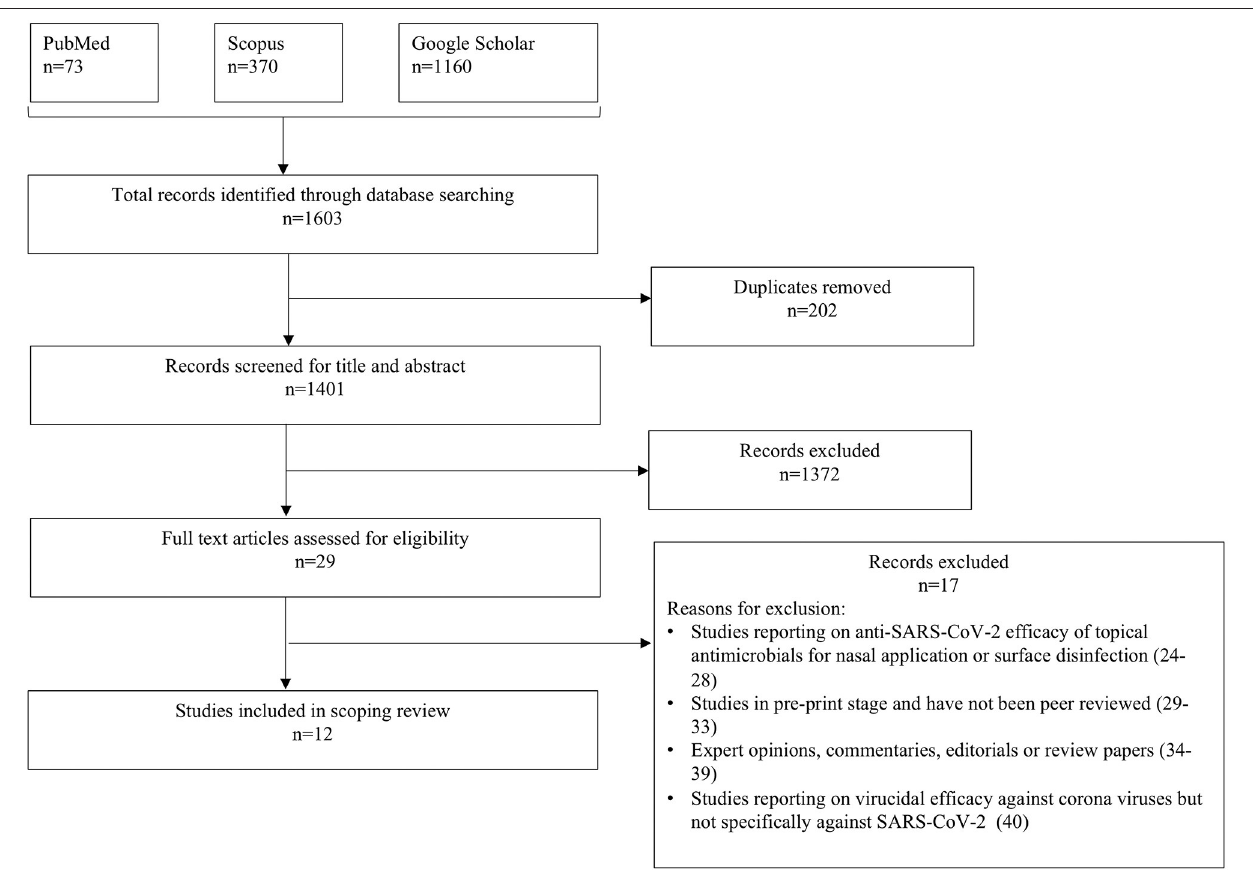
FIGURE 1 | Flowchart of strategy for literature search and